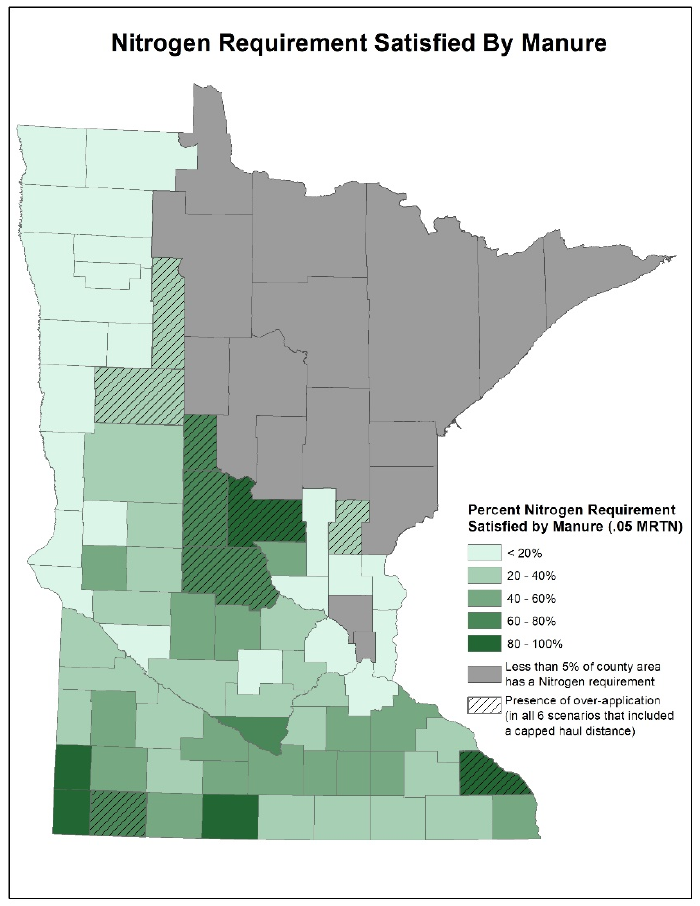
Figure 3. County Nitrogen Requirement Satisfied by Manure and Areas of Over-Application.